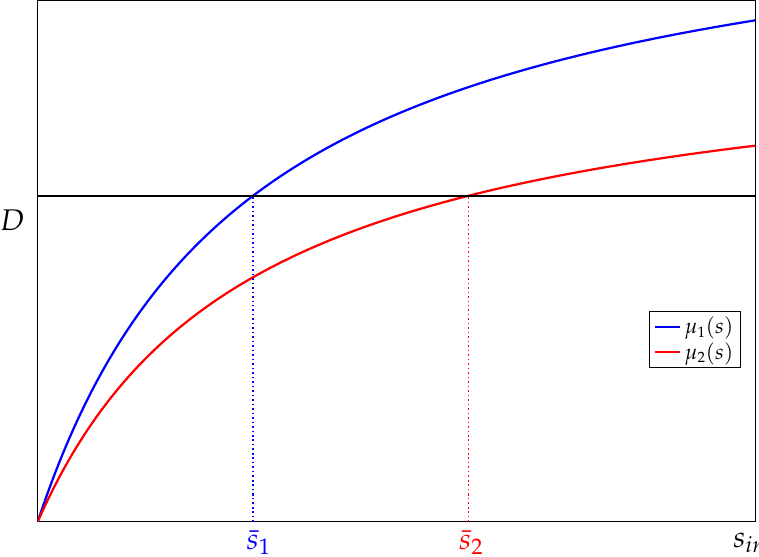
Figure 3. Typical growth rates where ¯ s 1 < ¯ s 2 < s in .